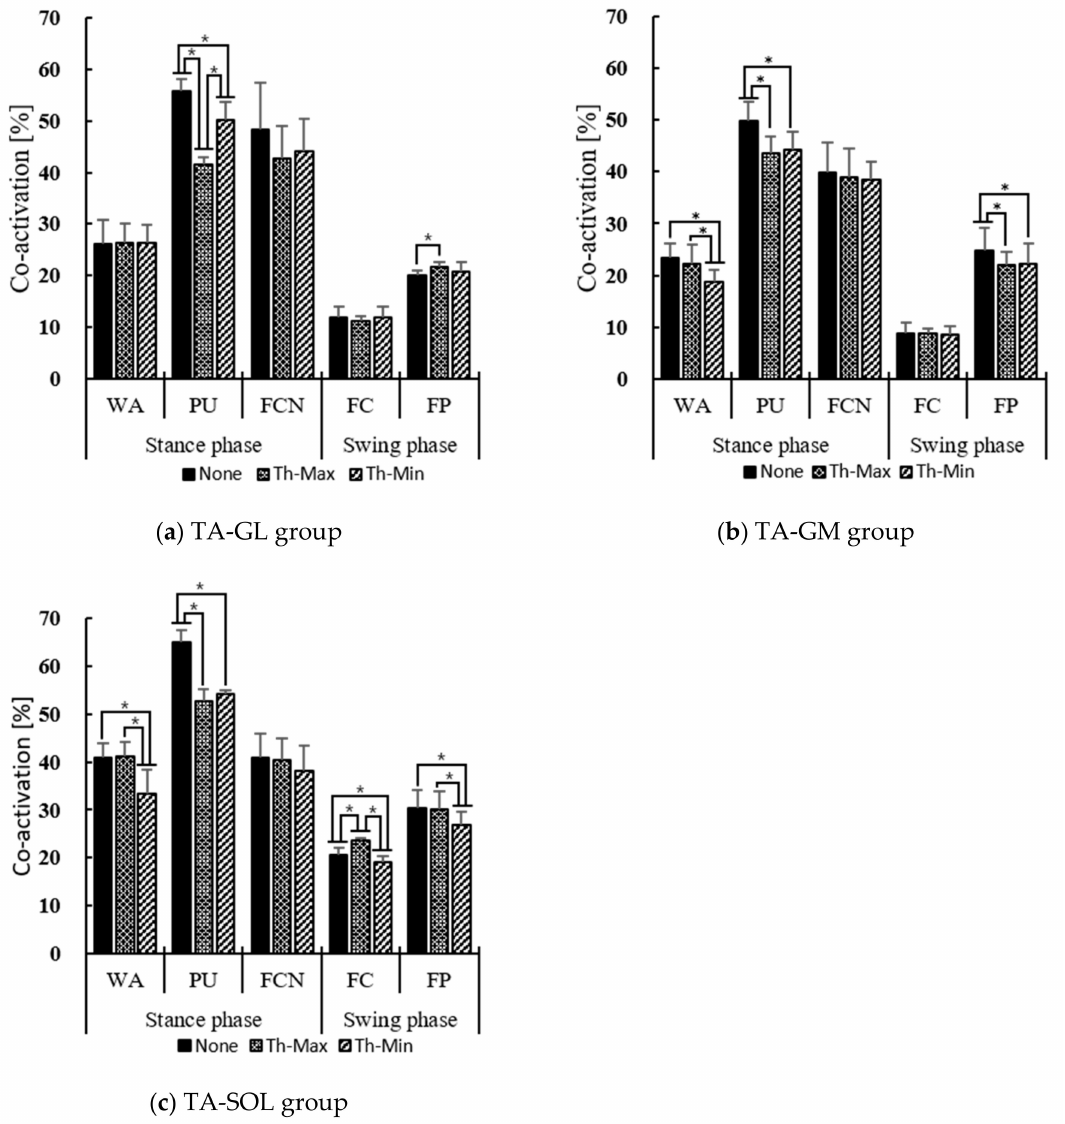
Figure 4. Mean value ( ± standard deviation) of co-activation of each gait phase according to the vibratory stimulation conditions at threshold intensity of each muscle group: ( a ) TA-GL group, ( b ) TA-GM group, ( c ) TA-SOL group, * indicates statistical significance through post-hoc tests between vibratory stimulus conditions ( p <